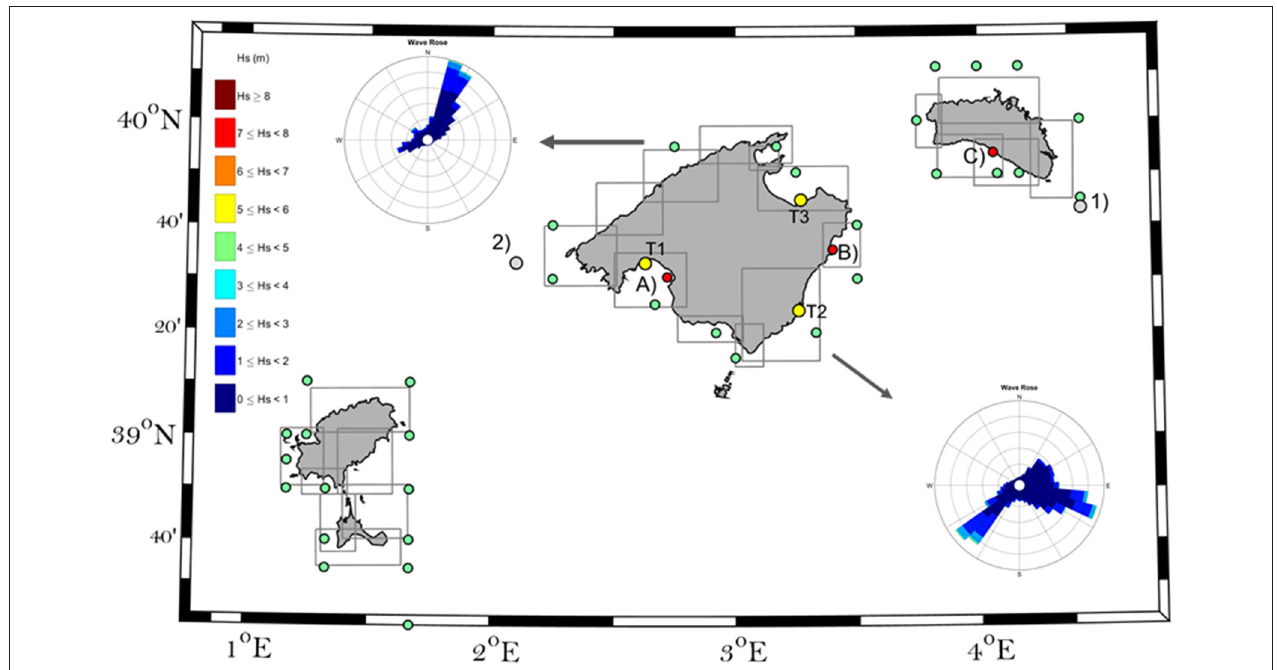
FIGURE 1 | Study area and data availability: Offshore wave buoys, grey dots, (1) Mahon Buoy and (2) Sa Dragonera buoy, coastal Acoustic Waves and Currents Sensors (AWACS), red dots, (A) Playa de Palma, (B) Cala Millor and (C) Son Bou and tide gauges, yellow dots, (T1) Palma, (T2) Portocolom and (T3) Colonia de San Pere. The SWAN model grids are represented by the grey rectangles while the offshore waves from the climate simulations used to force SWAN are represented by a green dot. Two waves’ roses represent the offshore maritime climate given in the North (top left rose) and the South (bottom right rose). Note that the Hs values are represented by a colour bar at the left of the